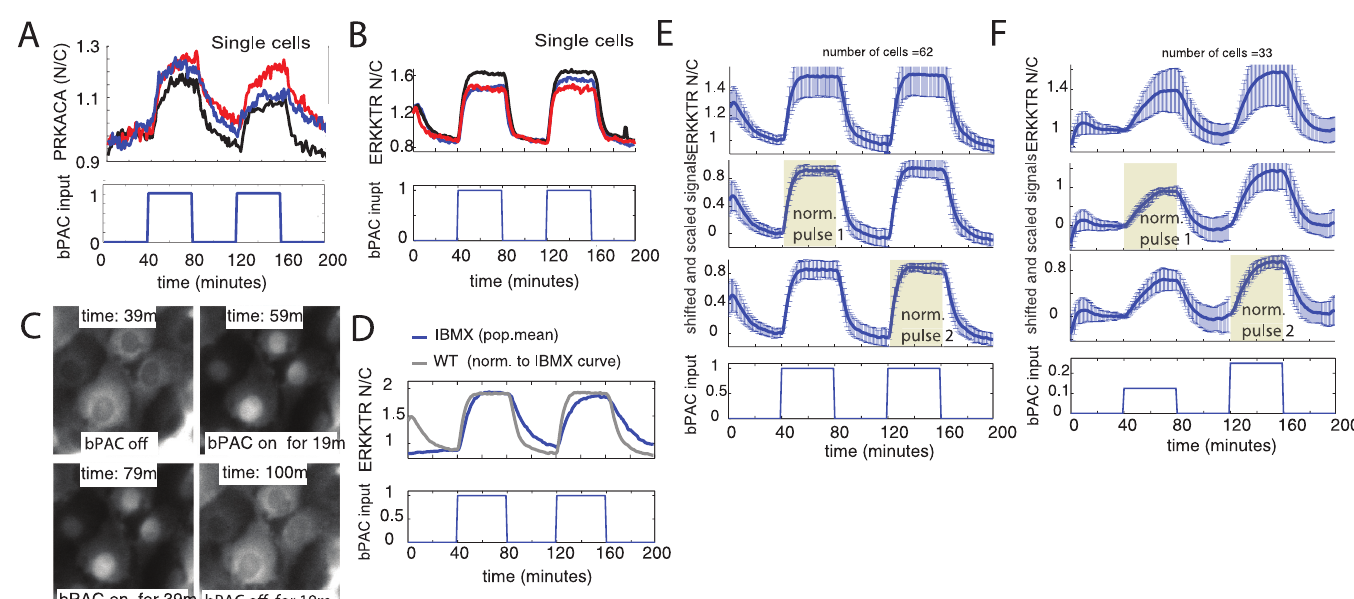
Fig 2. bPAC induced emitters in all-emitter monolayers tend to have a simple, time-dependent ERK inhibition response. (A) Periodic activation of bPAC (lower plot) results in periodic activation of PKA in single cells (upper plot). (B) Periodic activation of bPAC (lower plot) results in periodic ERK inhibition visualized by the increased ERK Kinase Translocation Reporter (ERK-KTR) nuclear to cytoplasmic ratio N/C in single cells (upper plot). (C) Time dependent snapshots of ERK-KTR reporter from experiment presented in (B). Here nuclear localization correlates with bPAC activity. (D) Periodic activation of bPAC (lower plot) in the presence of PDE inhibitor (IBMX) exhibits slower turn off of ERK inhibition (upper plot: blue, population mean) after each pulse than with no drug (upper plot, grey, normalized to blue for comparison). (E and F) Calculation of the population mean and standard deviation of the ERK-KTR N/C signal under different normalization approaches. Top 3 plots: For a given normalization approach, each single cell ERK-KTR N/C signal is shifted such that the signal at the beginning of the first pulse is zero and then normalized. Mean and standard deviation are calculated to just before the start of the second pulse. This process is the then repeated for the second pulse enforcing the standard deviation is zero at the beginning of each pulse. Top plot: mean ± standard deviation. Second plot from top: mean ± standard deviation calculated after each shifted signal is normalized by difference between the peak value of the signal during the first pulse and the value at the beginning of the first pulse. This removes the effects of peak amplitude variability in the first pulse. Third plot from top: same as prior normalization approach of the first pulse, but applied to the second pulse instead. This removes the effects of peak amplitude variability in the second pulse. Bottom plot: bPAC input pulse sequence. (E) All-emitter monolayer with identical bPAC input pulse amplitudes. (F) All-emitter monolayer with increasing bPAC input pulse amplitudes. For both (E) and (F), standard deviation is most constrained during the chosen pulse that removed the effects of peak amplitude variability (highlighted regions). Note that for some experiments one observes a decaying transient in the ERK-KTR N/C signal during the first 40 minutes when the the light is off (see single emitter examples in (B)). This occurs from exciting bPAC when searching for suitable cells to image with light that overlaps the spectrum that excites bPAC.